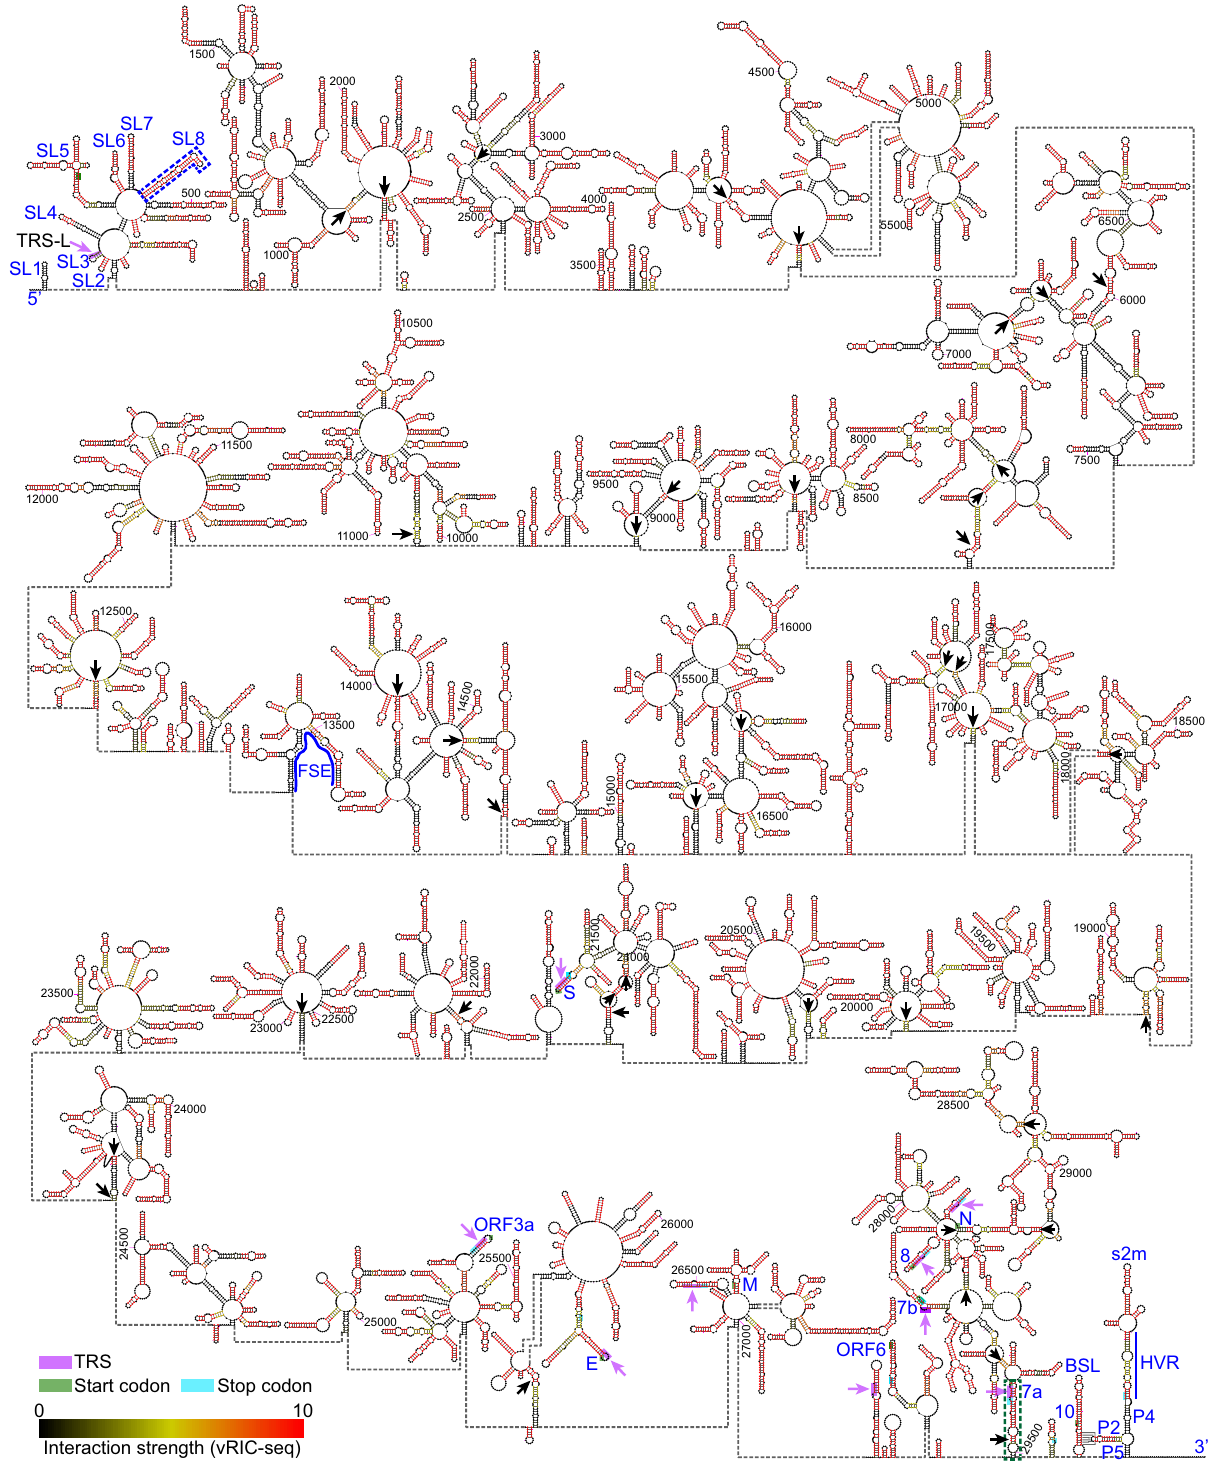
Fig. 3 The secondary structure of the SARS-CoV-2 genome. The known structural elements in the 5 ′ UTR, the frame-shifting element (FSE), and the 3 ′ UTR are labeled or marked in blue. The pairwise interaction strength was quanti fi ed and shown in different colors. Black arrows highlight highly con fi dent long-range duplexes measured by vRIC-seq signals. Green and cyan boxes mark the start and stop codons, respectively. Purple boxes and arrows outline the core sequence (CS) of each transcription-regulatory sequence